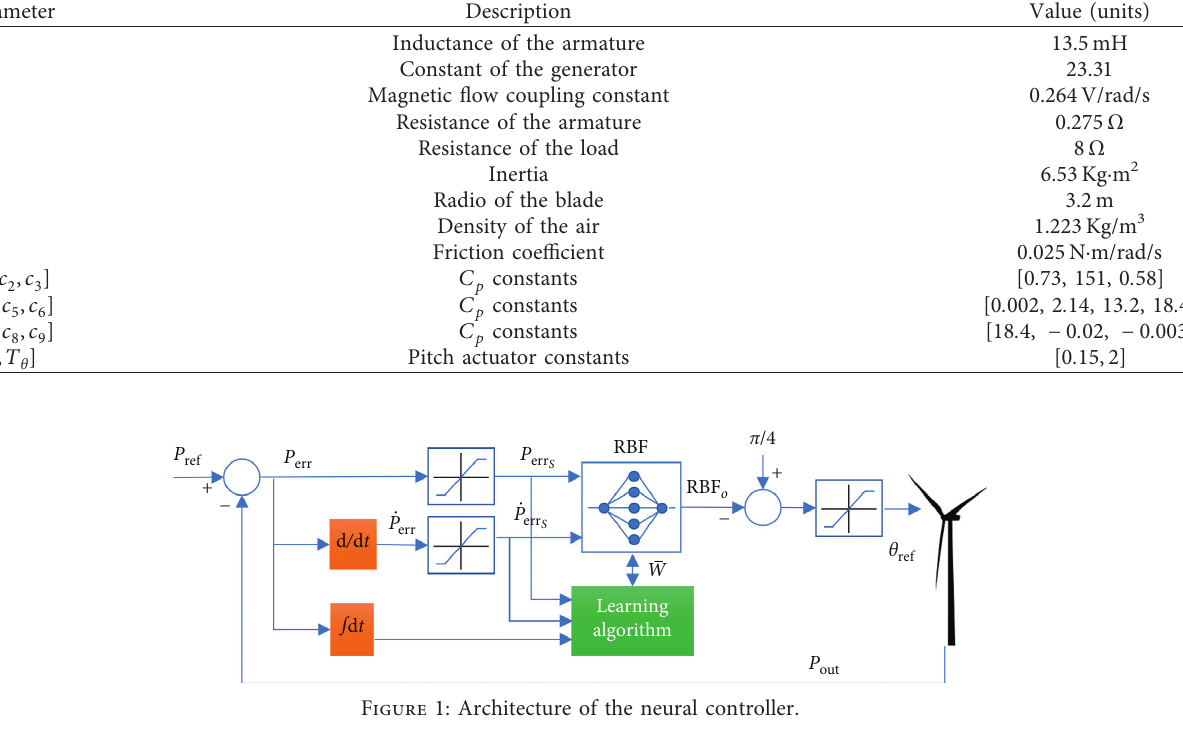
Table 1: Parameters of the wind turbine model.